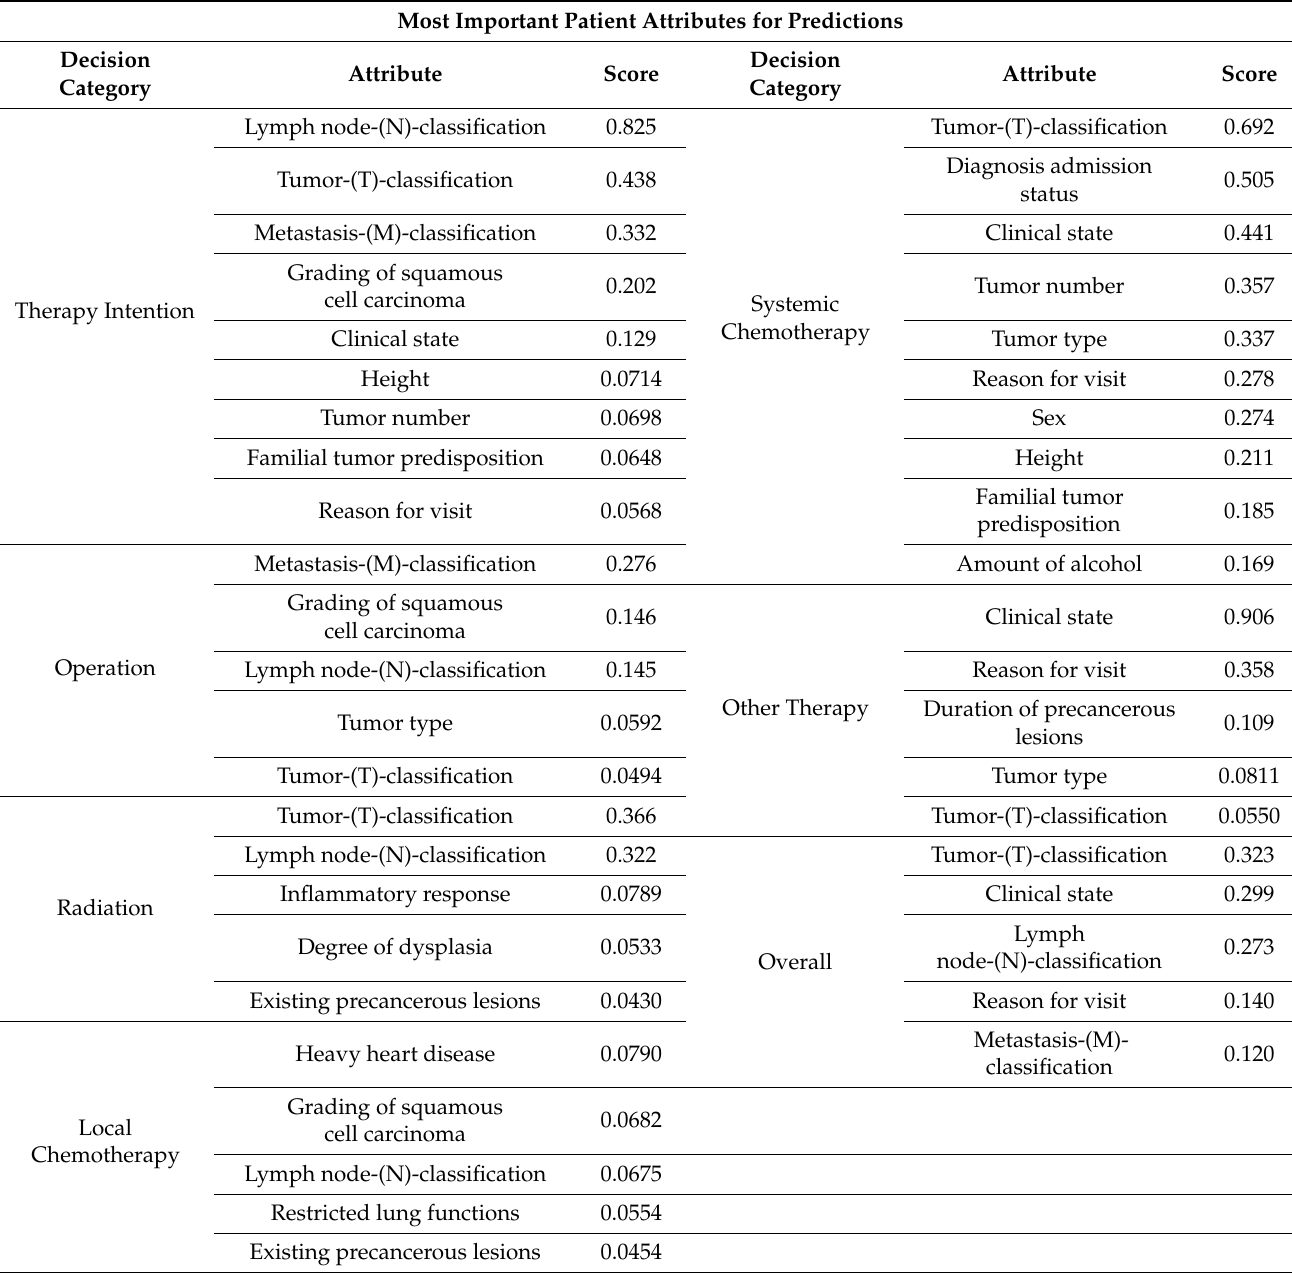
Table 3. Most Important Attributes and Scores for Each Prediction Task (Tofangchi et al. 2017). Most Important Patient Attributes for